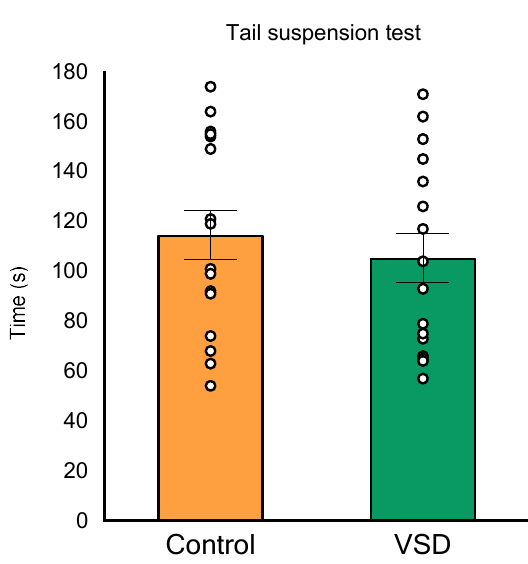
Figure 5. Vicarious Social Defeat (VSD) did not increase time in immobility in the tail suspension test (TST). Bars depict the mean ± SEM of the time (seconds) during which the mice remained immobile in the TST (control group, n = 16; VSD group, n = 16).